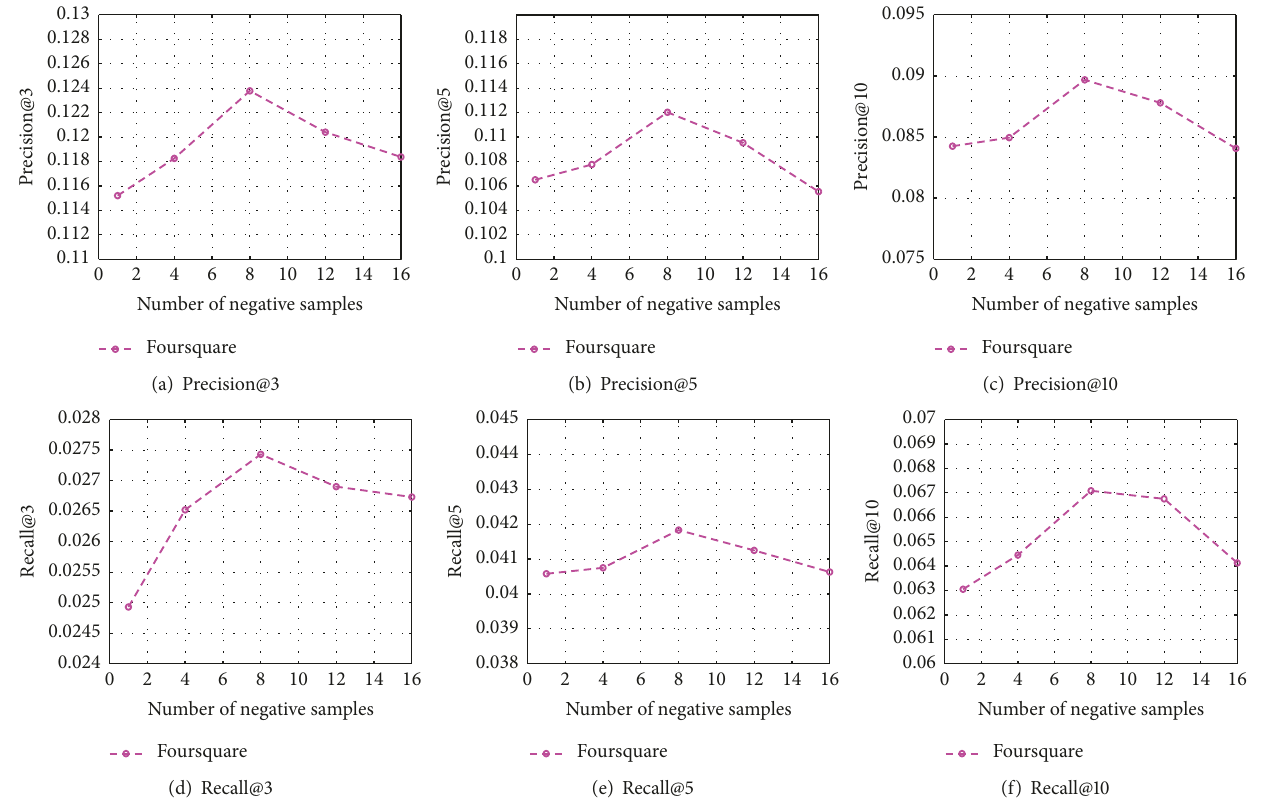
Figure 2: The impact of negative